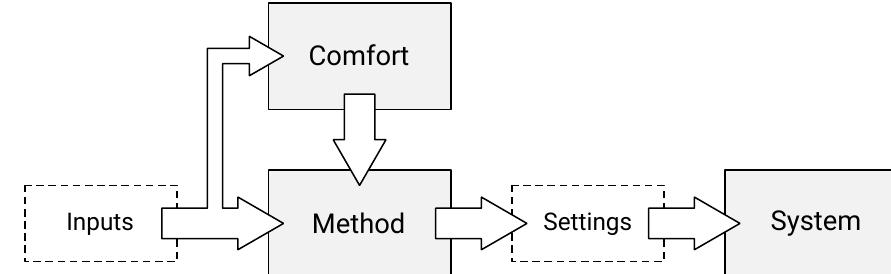
Figure 5. Blocks of thermal-comfort-based control